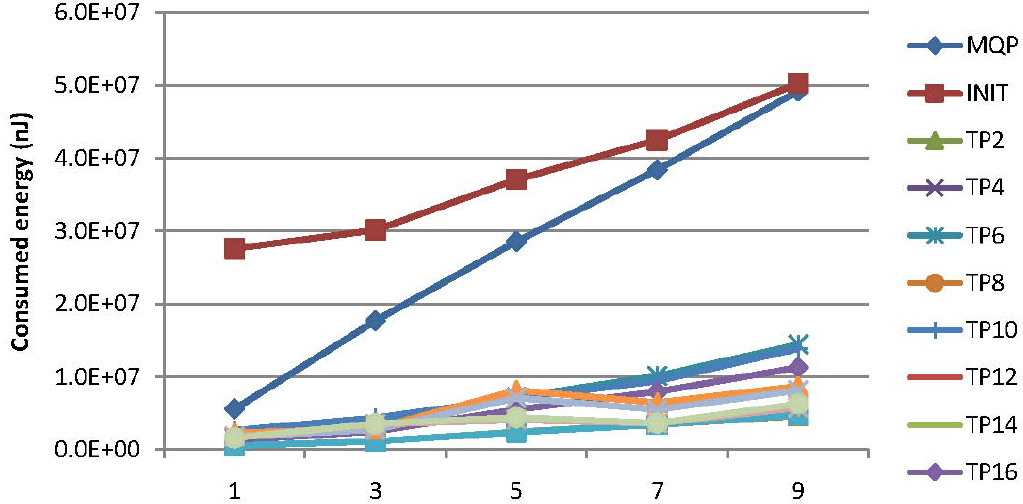
Figure 12. Comparison of energy consumption of our PCC and MQP [33] for the query types of MAQWR and SAQWR, where the number of attributes are set to 1, 3, 5, 7 and 9, respectively. This figure shows that more energy is consumed for our PCC than MQP at the first time point (denoted INIT), while much less energy is consumed